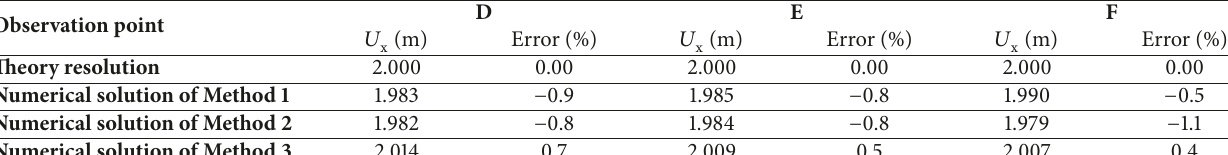
Table 5: Displacement maximums of different boundary methods and their relative error in the X direction.